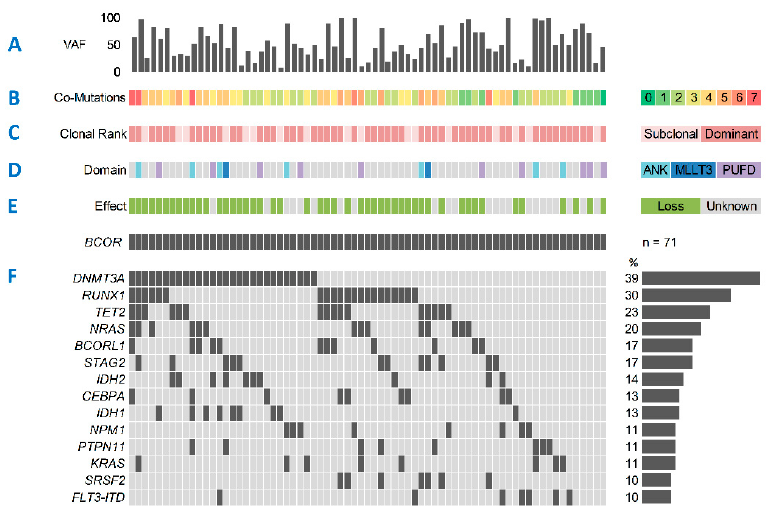
Figure 1. Mutational spectrum of BCOR -mutated AML. ( A ) BCOR variant allele frequency (VAF) percentages. ( B ) Number of co-mutations in addition to mutated BCOR . ( C ) Clonal rank of BCOR mutations determined by comparing BCOR VAF to co-mutated somatic driver variants. ( D ) Mutated BCOR domain, undetermined (grey). ( E ) Effect of mutated BCOR , loss-of-function (transcriptional stop, green), or unknown (no transcriptional stop, grey). ( F ) Most common co-mutations. Mutations with a frequency of <10% not shown: ASXL1, GATA2, WT1, SF3B1, U2AF1, TP53, ZRSR2, IKZF1, KIT, ETV6, EZH2, FLT3-TKD, JAK2, PHF6, CBL, CBLB, CSF3R, NOTCH1, PDGFRA, SMC3 .